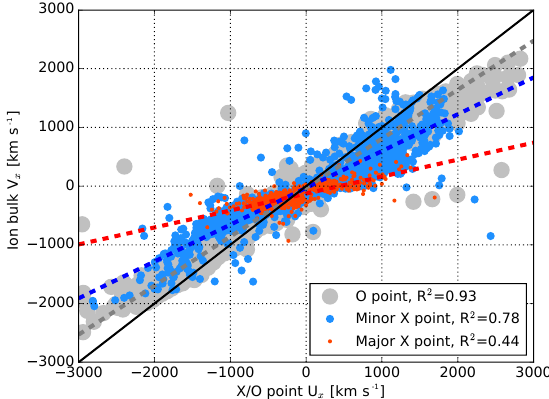
Figure 9. Earthward velocity of magnetotail plasma sheet O points, minor X points, and major X points as a function of ion V x esti- mated at the locations of the X and O points. The line of equality is shown in solid black and linear fits to the O point values, minor X point values, and major X point values in dashed gray, blue, and red, respectively.